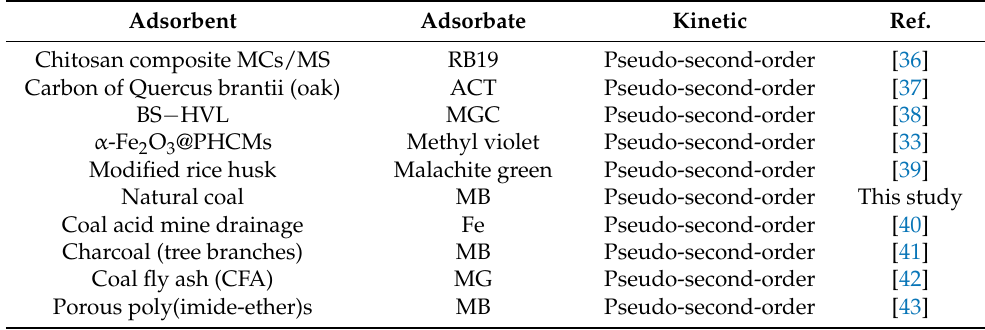
Table 5. Comparison of kinetic model for the adsorption of MB onto coal with other published